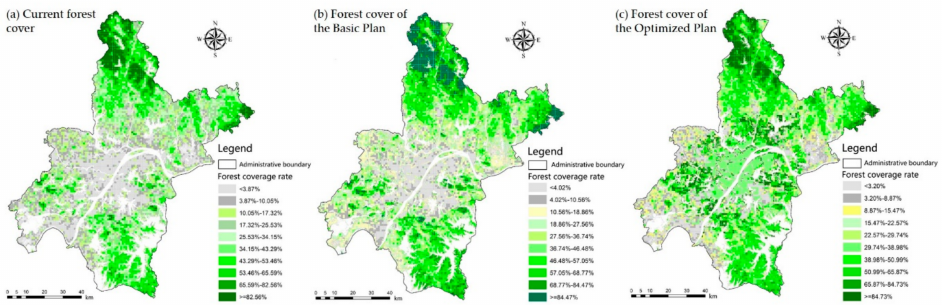
Figure 4. Distribution of forest cover in di ff erent schemes: ( a ) The current forest cover, ( b ) the basic plan, and ( c ) the optimized plan.